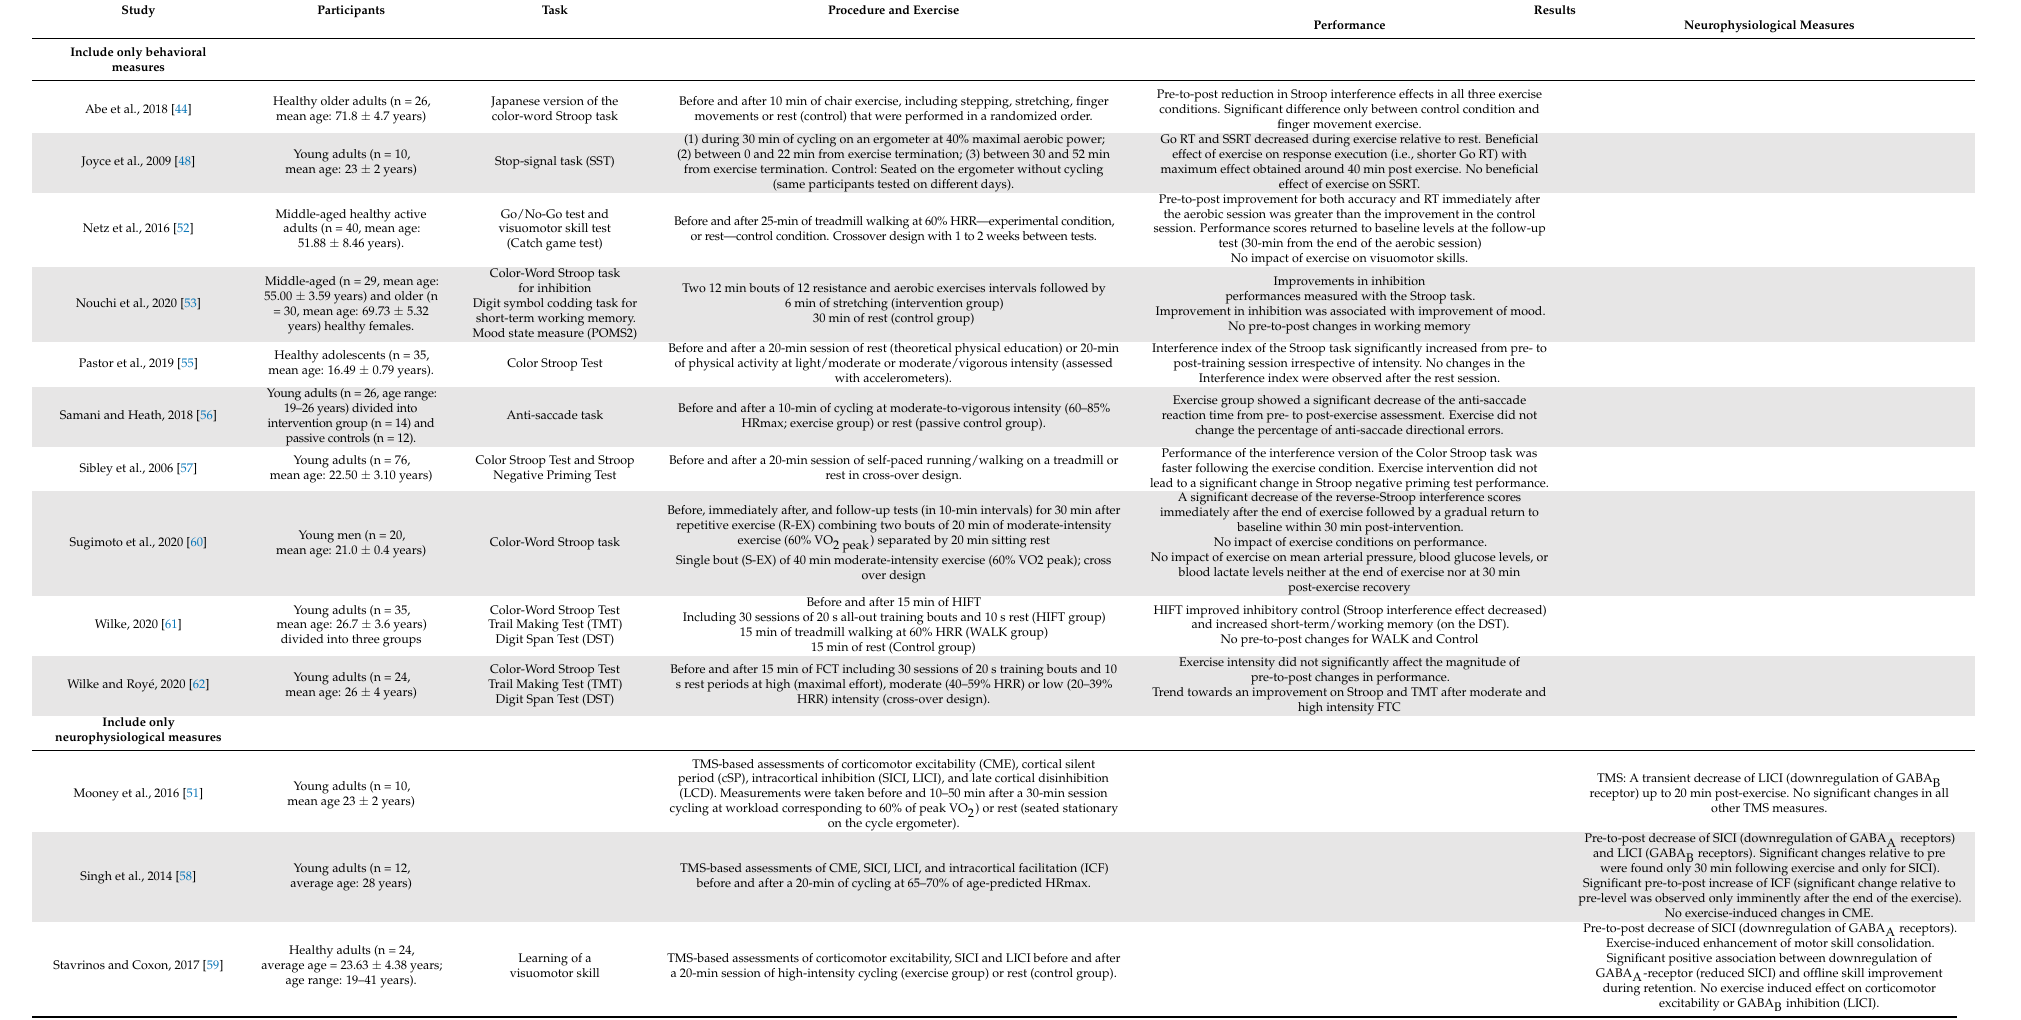
Table 1. A summary of the 22 studies that examined motor and cognitive inhibition after an acute bout of